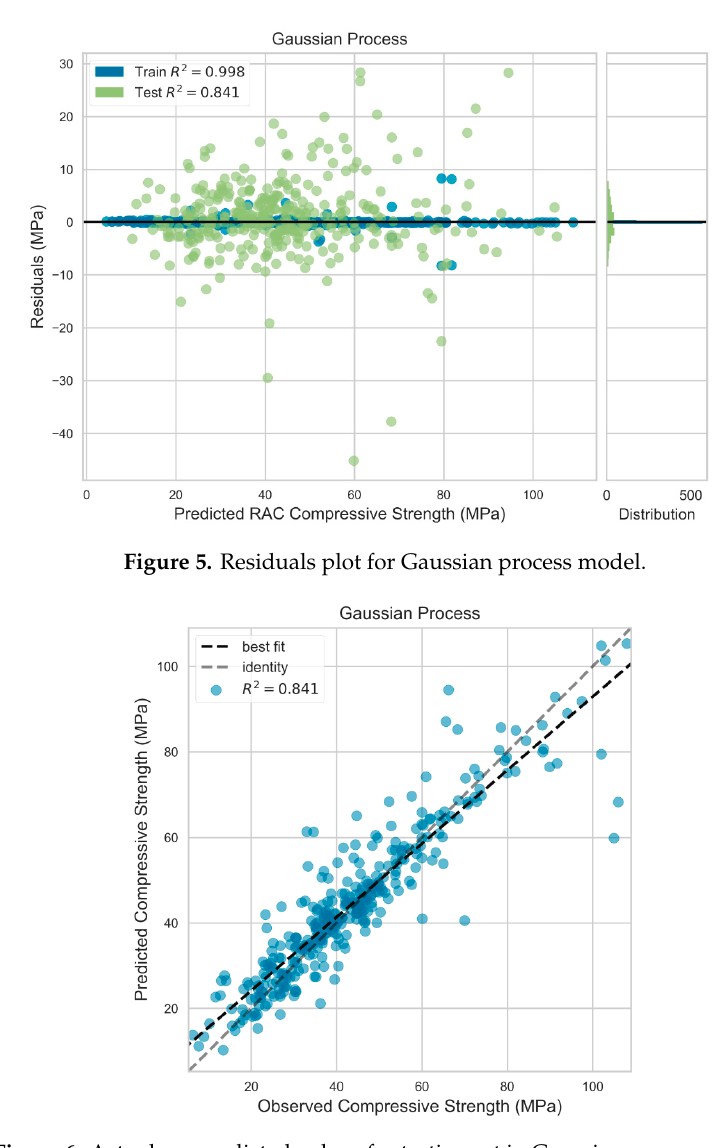
Figure 6. Actual vs. predicted values for testing set in Gaussian process model.